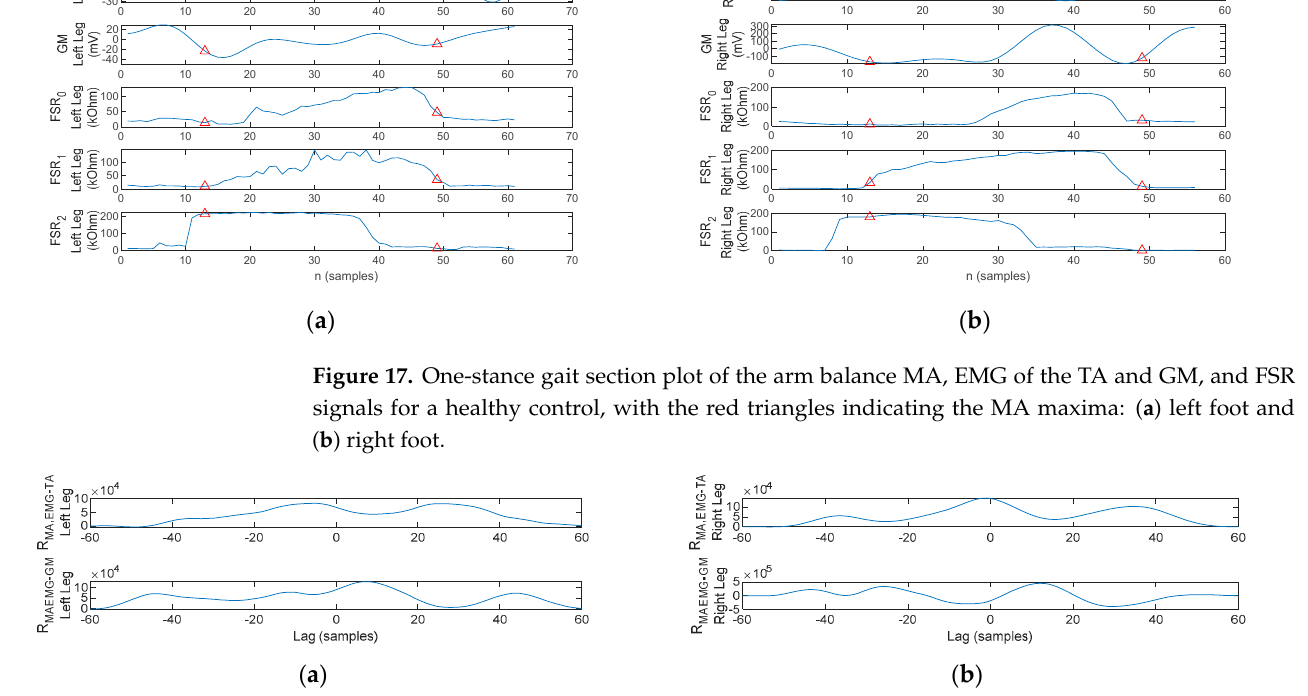
Figure 18. Cross-correlation of the MA and EMG signals plotted in Figure 17 for the ( a ) left foot and ( b ) right foot.